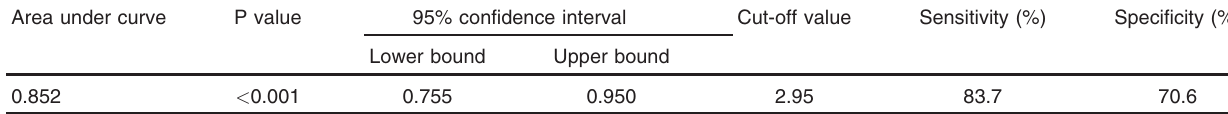
Table 8 Predictive value of diaphragmatic excursion for chronic obstructive pulmonary disease severity assessment Area under